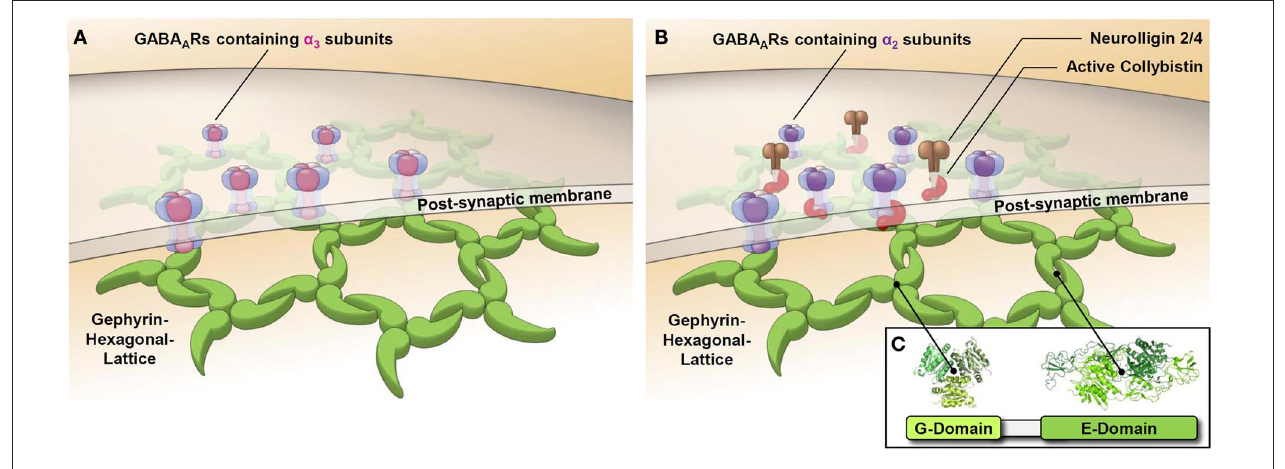
FIGURE 2 | Synaptic GABA A Rs containing the α 2 or α 3 subunit are clustered by different mechanisms. Schematic representations of GABAergic post-synapses containing the GABA A R α 3 subunit (A) or the GABA A R α 2 subunit (B) show the postulated differential role of collybistin in synaptic cluster formation. GABA A Rs containing the α 3 subunit directly